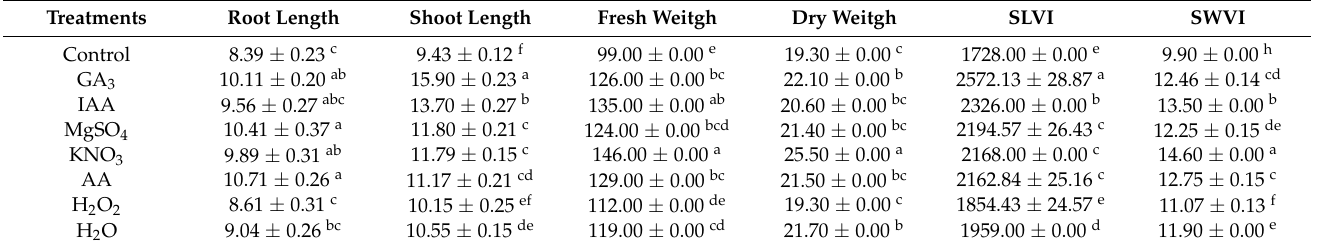
Table 1. Effect of different priming treatments on shoot and root length (cm), fresh and dry weight (mg), seedling weight vigor index (SWVI), and seedling length vigor index (SWVI) of wheat.